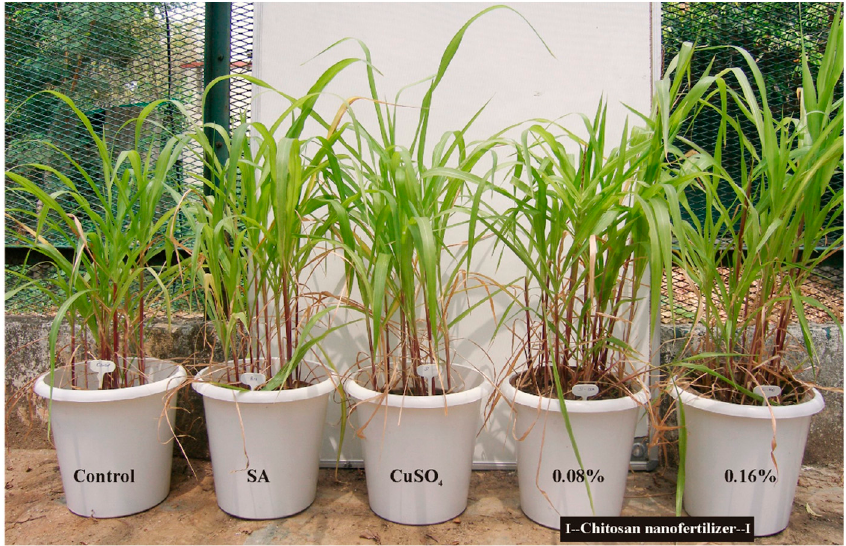
Figure 4. Chitosan bionanofertilizer impact on plant development (Reprinted from Sharma et al.